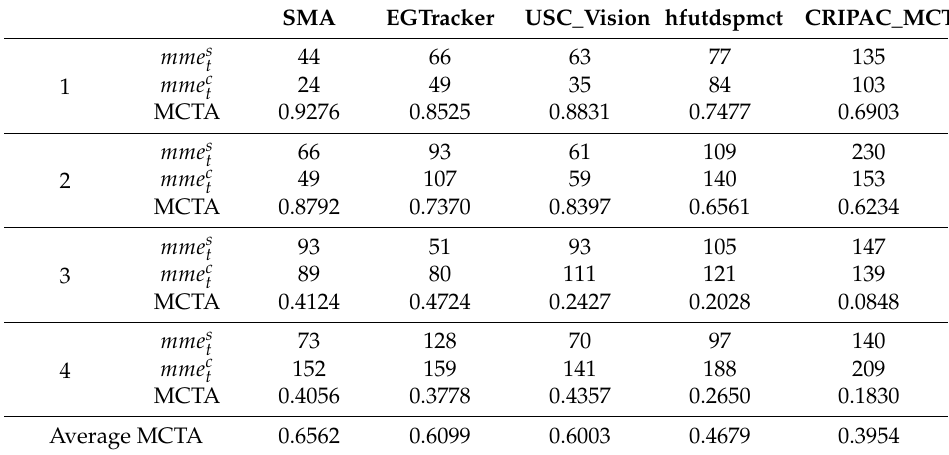
Table 3. Performance comparison when input is ground truth of object